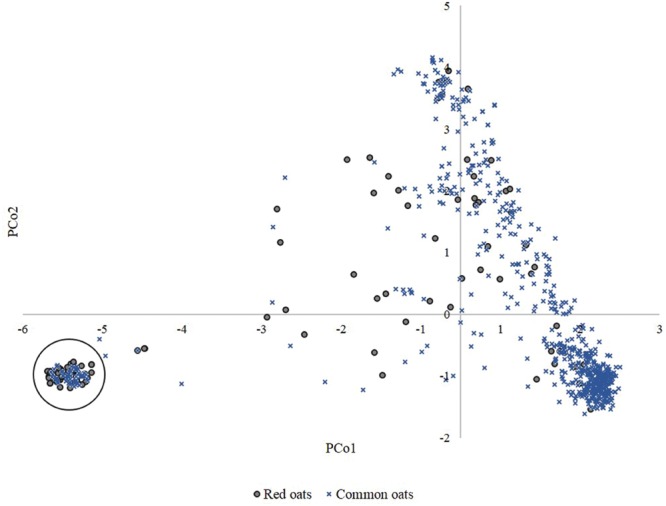
Principal coordinates 1 vs. 2 plotted for 759 oat accessions and colored according to classification as ‘red’ or ‘common’ oat. Cluster 1 is circled.